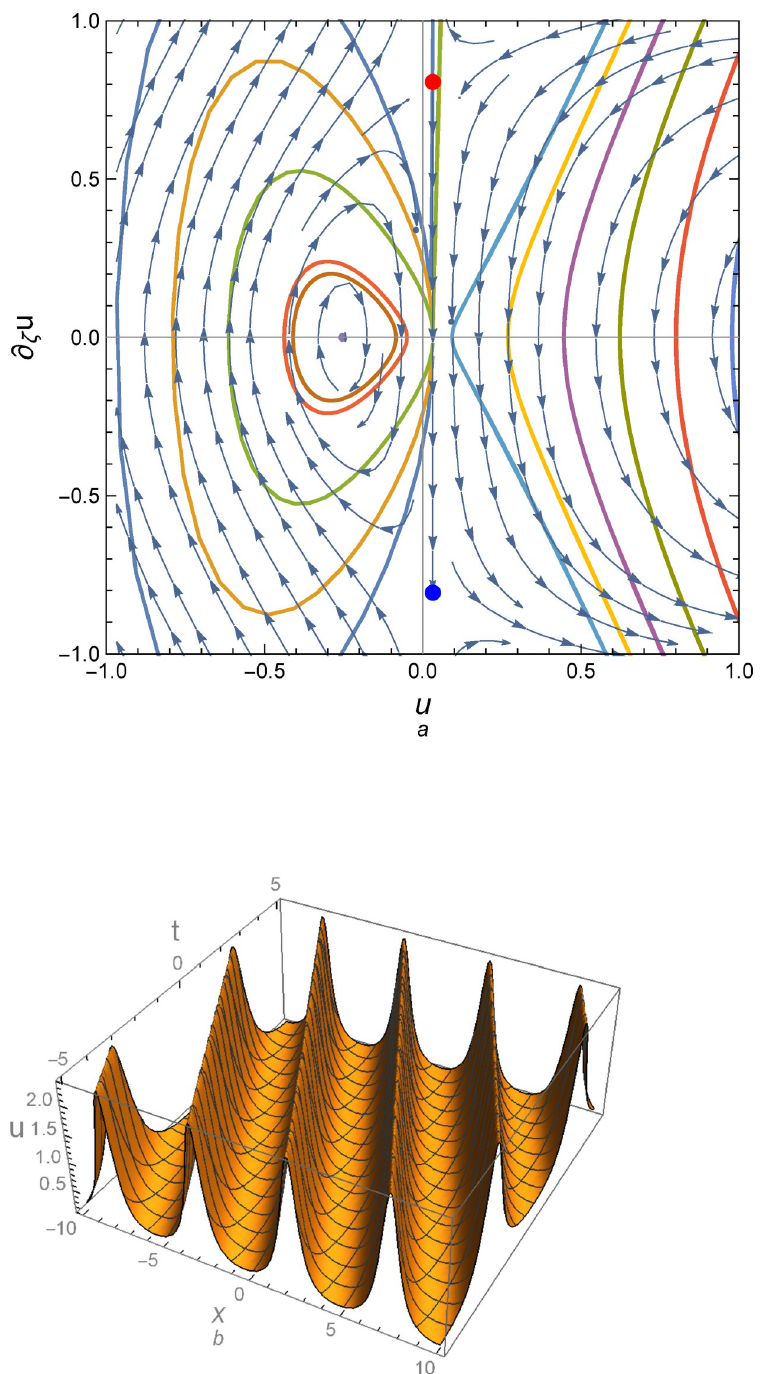
Fig 5. Periodic peakon solution for the parametric values c 0 = 1, c 1 = − 1.5, c 2 = 1, c 3 = 1.87316, α = 1, γ = 1, ε = 1, λ = 0.94, k = 1, D = 0.59 and (b) Profile of periodic peakon solution for the same parametric values.